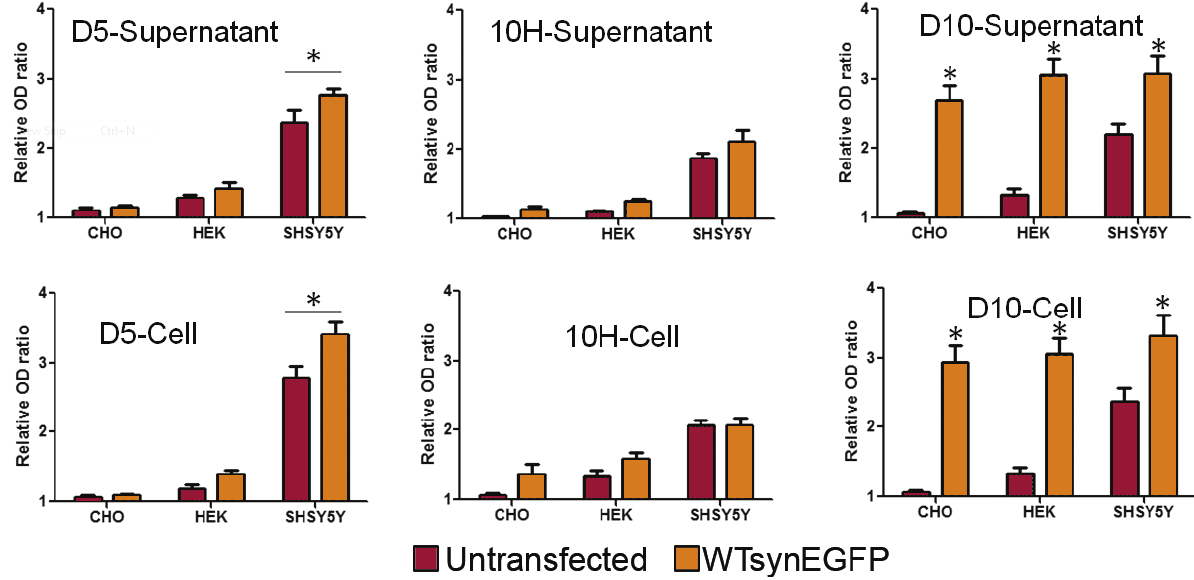
Figure 5. The levels of total (cid:2)-synuclein (D10) and D5 and 10H reactive oligomeric (cid:2)-synuclein aggregates in cell supernatant and lysate with endogenous and overexpressed levels of (cid:2)-synuclein. Levels of the different (cid:2)-synuclein species were determined by capture ELISA (D5 and 10H) or by indirect ELISA (D10) [49]. Cells (10 5 /mL) were seeded in a six well plate and transfected with or without wt-synuclein-EGFP. (cid:2)-Synuclein levels are expressed as the mean value of three measurements ± standard